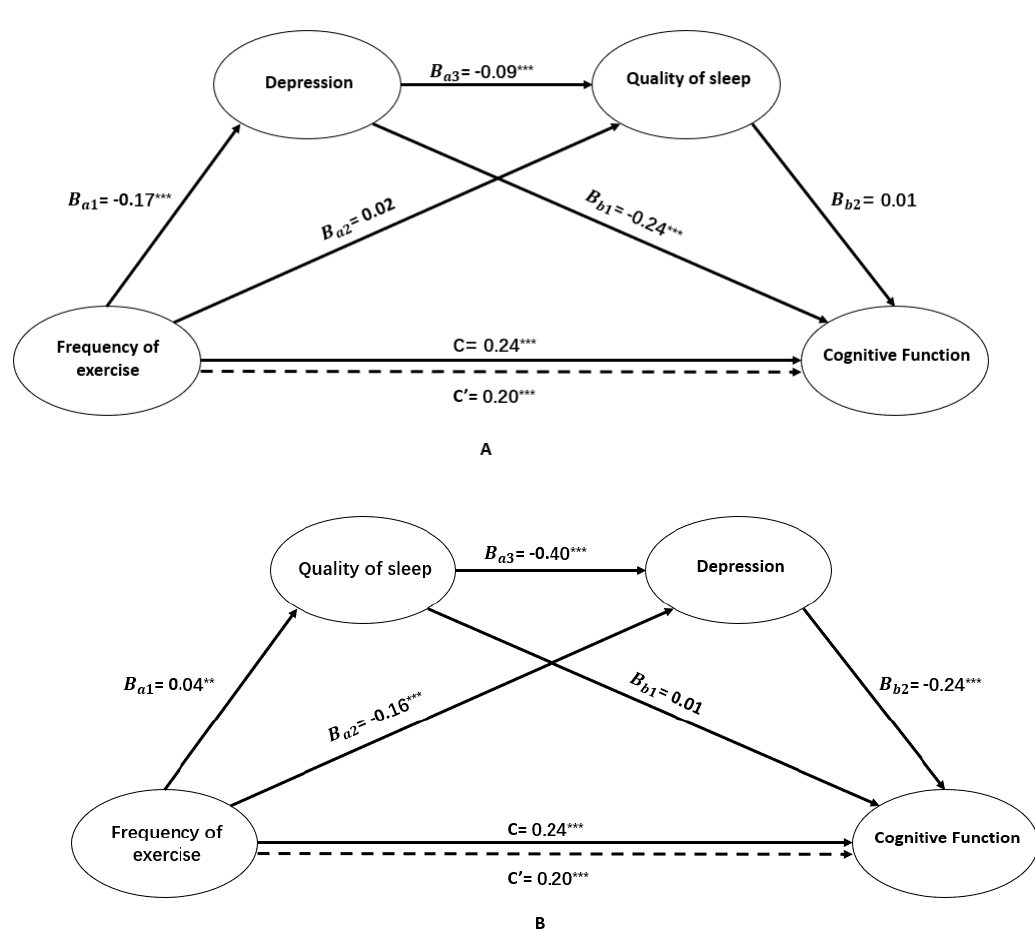
Figure 1. The serial multiple mediation role of depression and quality of sleep in the relationship between frequency of exercise and cognitive function and unstandardized beta values. c and c’ represent the total e ff ect and direct e ff ect of frequency of exercise on cognitive function, respectively. ** p < 0.01, *** p < 0.001. ( A ) presented serial-multiple mediation role of depression and quality of sleep in the relationship between frequency of exercise and cognitive function and unstandardized beta values for all participants; ( B ) provided serial-multiple mediation role of quality of sleep and depression in the relationship between frequency of exercise and cognitive function and unstandardized beta